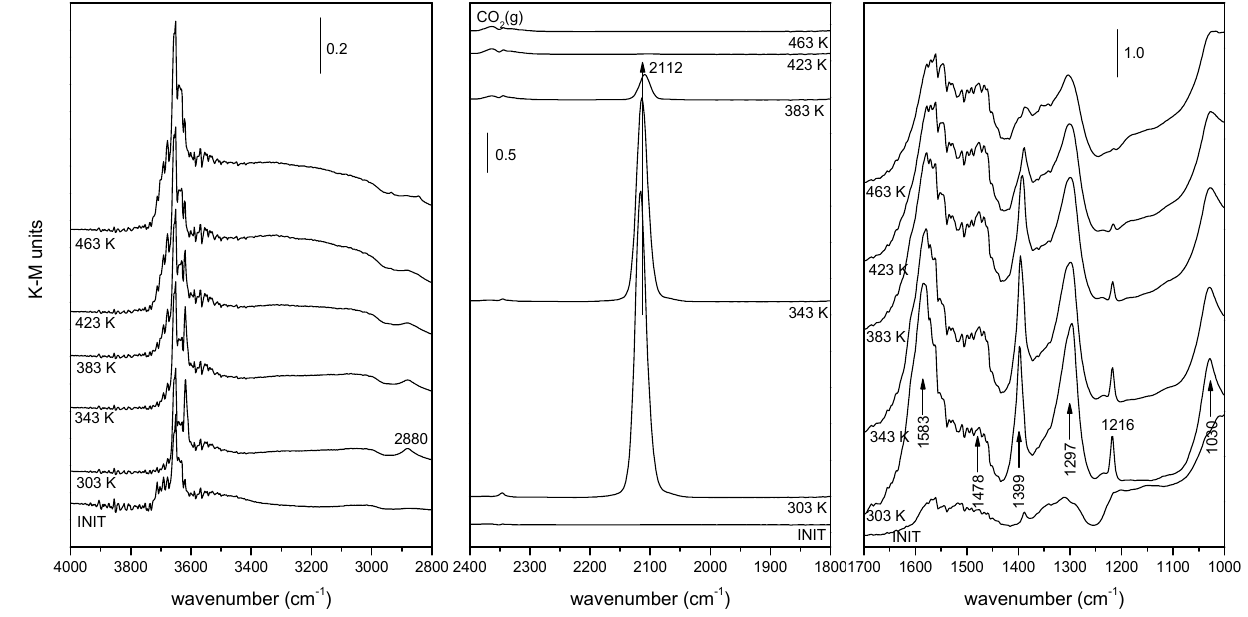
-O reactant mixture flow at the indicated Figure 6. DRIFTS spectra under CO-H 2 2 temperatures for 1CuO/CeO . The spectrum at the bottom corresponds to that recorded at 2 at 773 K, prior to contact with the reactant 303 K after pretreatment under diluted O 2 mixture. Note: This figure is adapted with permission from [40]. Copyright © 2007, American Chemical